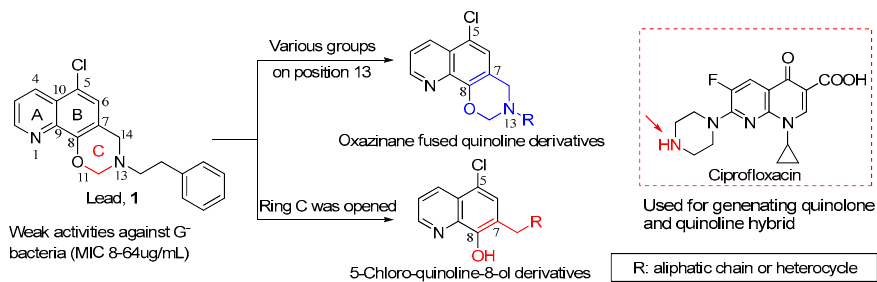
Figure 1. Chemical structure of compound 1 and structural modification strategies.